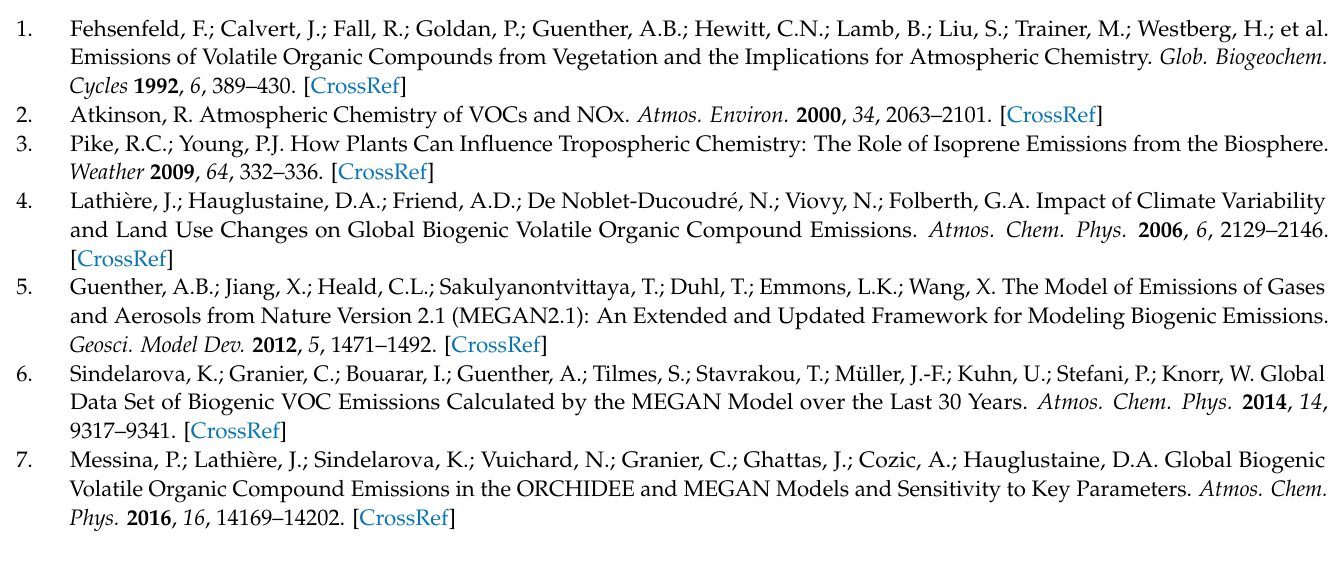
the MOFLUX site; Figure S5, Figure S6 and Table S2: Screening of OMI columns for effects of fires and aerosols; Figure S7: Global correlation coefficients with OMI HCHO columns. Reference [109] is cited in the Supplementary